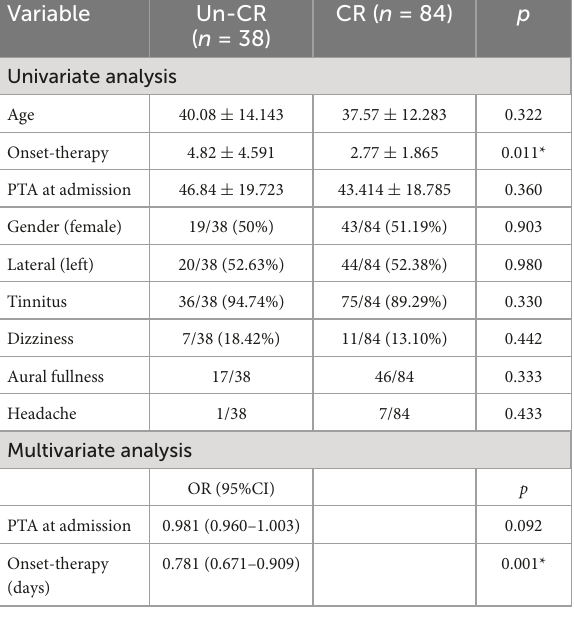
TABLE 3 Factors related to prognosis of ascending sudden sensorineural hearing loss